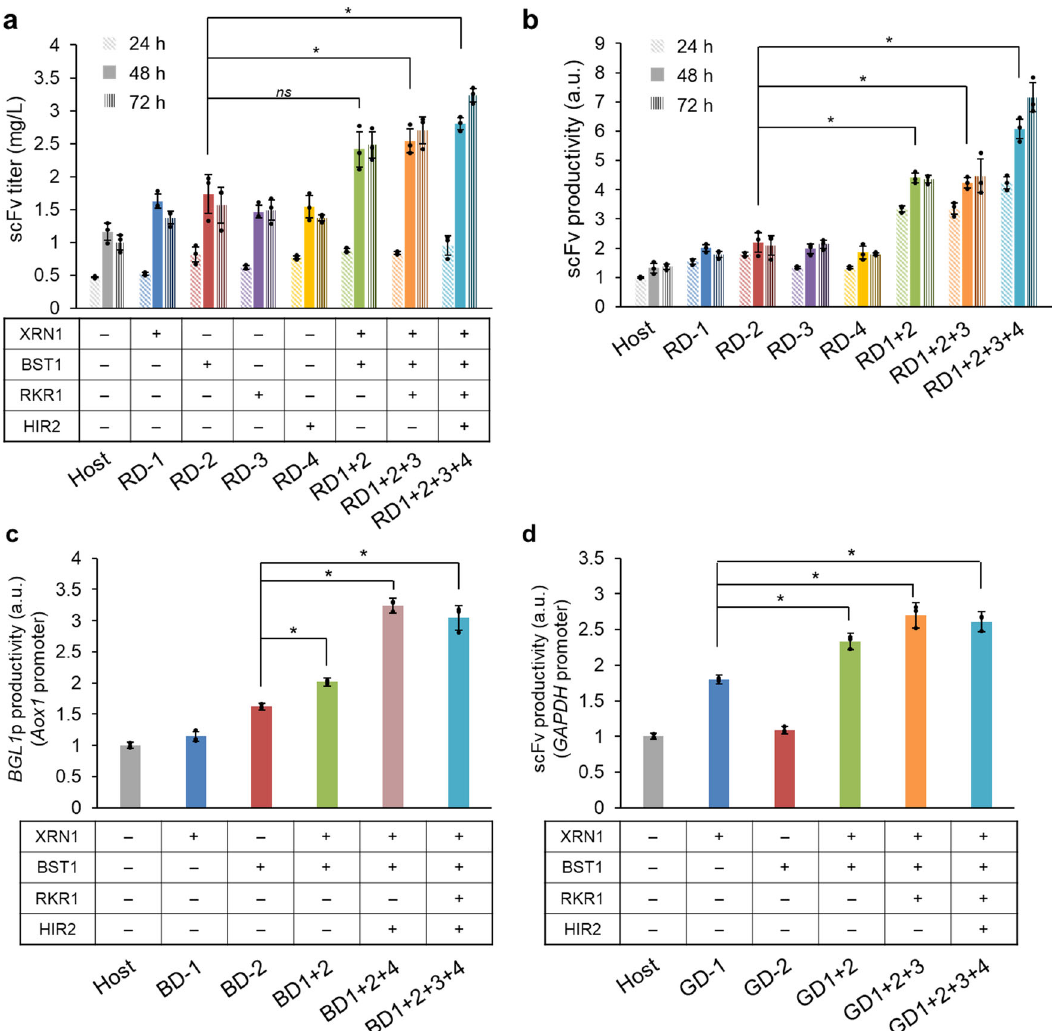
Fig. 3 Combined perturbation of gene-disruption-type effective factors in a single strain. a , b The scFv titer ( a ) and the productivity ( b ) (scFv titer per OD 660 value) in shake fl ask cultivation at 24 h (diagonal stripes), 48 h ( fi lled bars) and 72 h sampling (vertical stripes) after methanol induction are indicated. For each timepoint, scFv productivity was normalized to that of the host strain at 24 h. The scFv productivity of the multi-deletion strains (RD1 + 2, RD1 + 2 + 3 and RD1 + 2 + 3 + 4) were signi fi cantly higher than that of the single effective factor-disruption and the host strains. Error bars represent standard deviations from three biological replicates. Asterisks and “ ns ” indicate the signi fi cance level ( p < 0.05 by t -test) and non-signi fi cance level ( p > 0.05 by t -test) between the RD-2 strain (the best secretion strain among single effective factor disruptions) and the accumulated strains at 48 h methanol induction, respectively. c , d Effects of swapping of the secreted protein and promoter in combined gene-disruption-type effective factor strains. Relative productivities (BGL1p activity or scFv titer per fi nal OD 660 value) of host and gene-disruption(s) strains in test tube cultivation for 60 h are indicated. ( c ) AOX1 promoter-driven BGL1 and ( d ) GAPDH constitutive promoter-driven anti-lysozyme scFv constructs are indicated. Each productivity value was normalized to that of the host strain. Gray, blue, red, purple, yellow, yellow-green, orange and blue-green indicate the host, RD-1, RD-2, RD-3, RD-4, RD1 + 2, RD1 + 2 + 3 and RD1 + 2 + 3 + 4 strains, respectively. Error bars represent standard deviation from three biological replicates. Asterisks indicate that a signi fi cant difference was observed ( p < 0.05 by t -test) in the BD-2 or GD-1 strain (the best secretion strains among single effective factor disruptions) and the multi-gene-disrupted